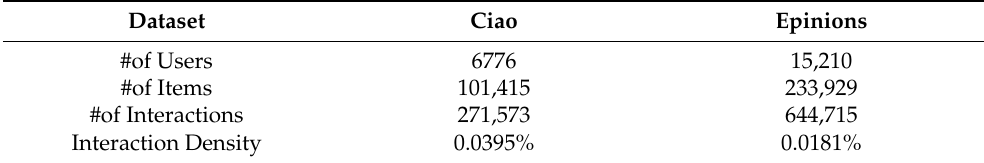
Table 3. Statistical information of the